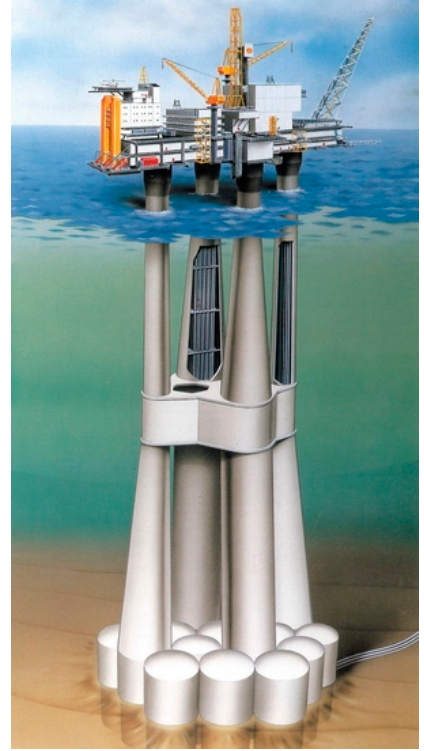
Figure 2. An example of Condeep oil storage platform: Troll A [3].